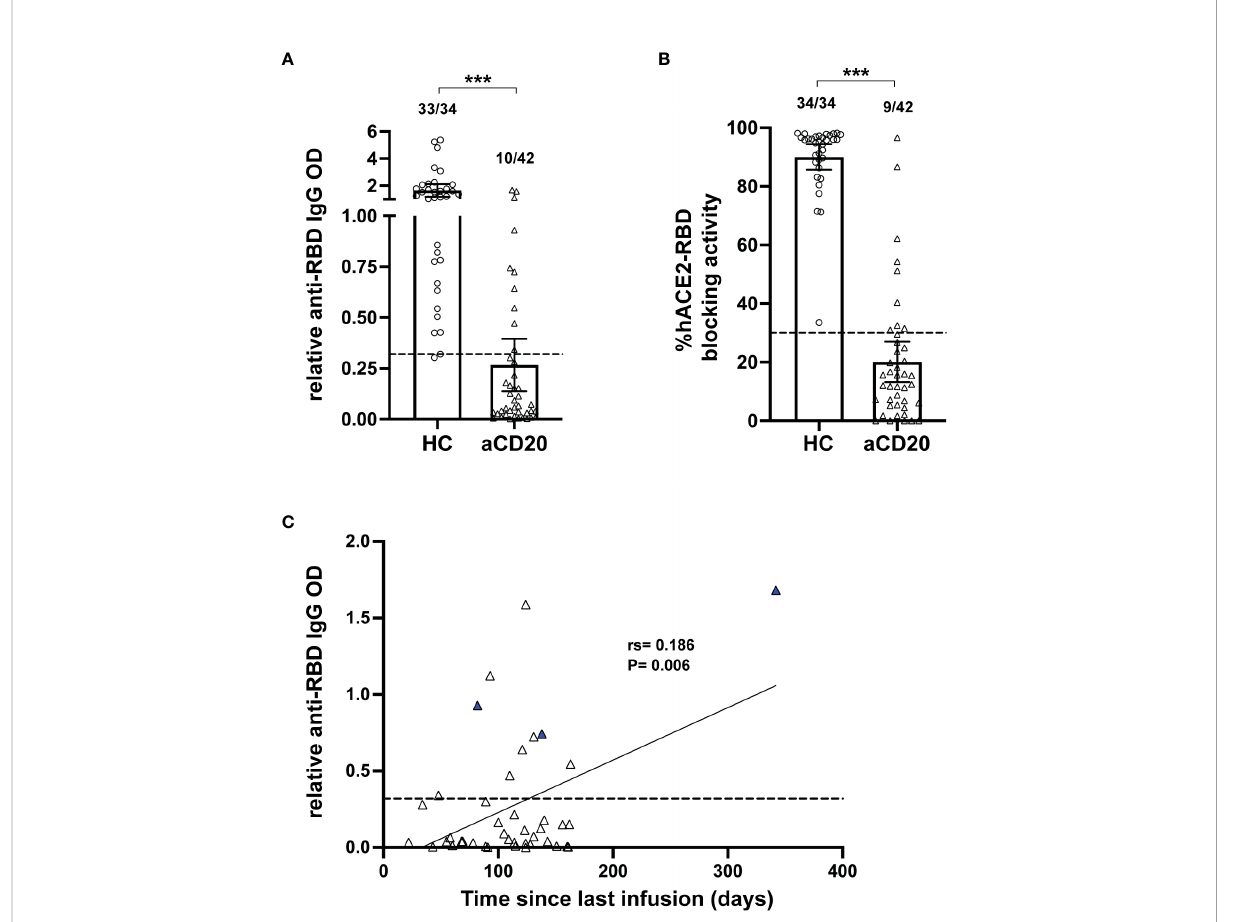
FIGURE 1 De fi cient humoral response in aCD20-MS compared to healthy controls. (A-C) Humoral response analysis performed with serum samples collected within 6 months after vaccination of healthy controls (open circles, n=34) and aCD20-MS patients (open triangles, n=42). Dots represent individual data points. (A) Comparison of anti-spike RBD IgG antibody titers from serum samples of healthy controls and aCD20-MS patients expressed as relative OD values. Box plots represent mean and 95% CI. Dotted line indicates limit of sensitivity (0.32) and represents mean + S.D. positivity cut-off obtained from unexposed individuals (n=51). Fractions of samples above limit of sensitivity are indicated on top of each dataset. *** P < 0.001; Mann-Whitney U tests. (B) Antibody-induced blocking activity of hACE2 binding to RBD was determined from serum samples using the SARS-CoV-2 Surrogate Virus Neutralization Test cPass ™ kit (GenScript) and expressed as % hACE2-RBD blocking activity. A percentage of 30% was used to determine positive RBD-hACE2 inhibition. Fractions of samples above positivity threshold are indicated on top of each dataset. *** P < 0.001; Mann-Whitney U tests. (C) Linear regression of the ratio of relative anti-RBD IgG OD value and time between last anti-CD20 infusion therapy and fi rst vaccination dose of aCD20-MS patients showing signi fi cant correlation between IgG titers and time post- last infusion. Blue triangles represent patients with B-cell counts higher than 20 cells per µL. Dotted line indicates limit of